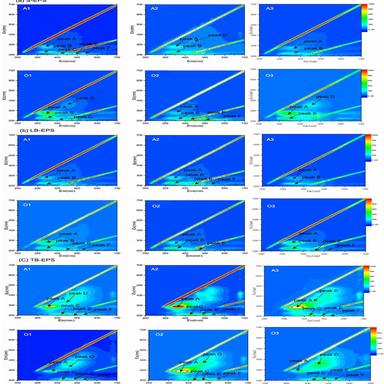
3D-EEM spectrum of EPS in different stages (a) S-EPS (b) LB-EPS (c) TB-EPS.